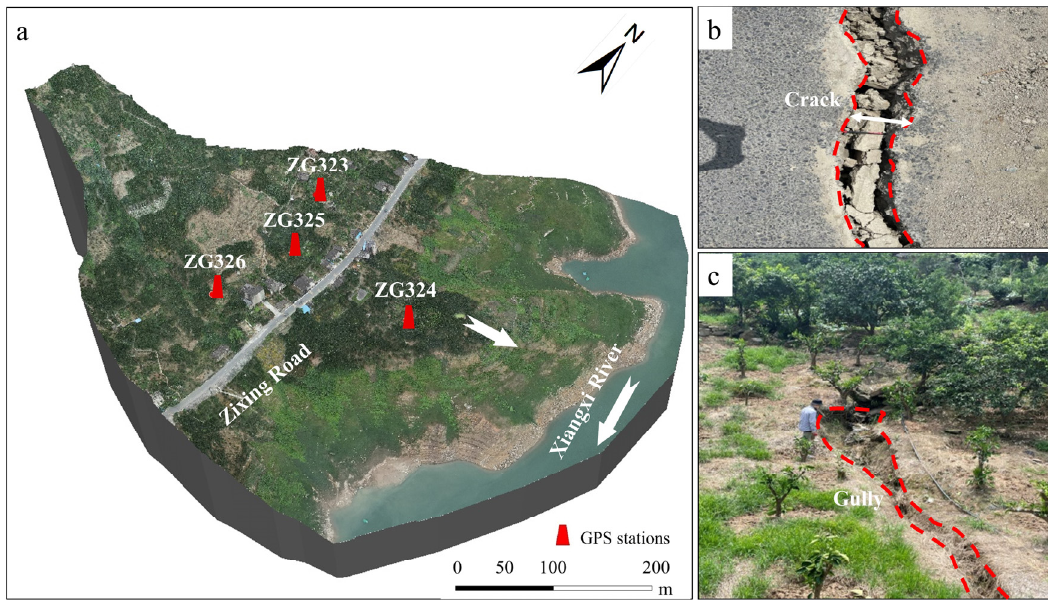
Figure 6. UAV field survey: ( a ) UAV 3D modeling of the landslide in July 2021; ( b ) a crack in the landslide; ( c ) a gully in the landslide.